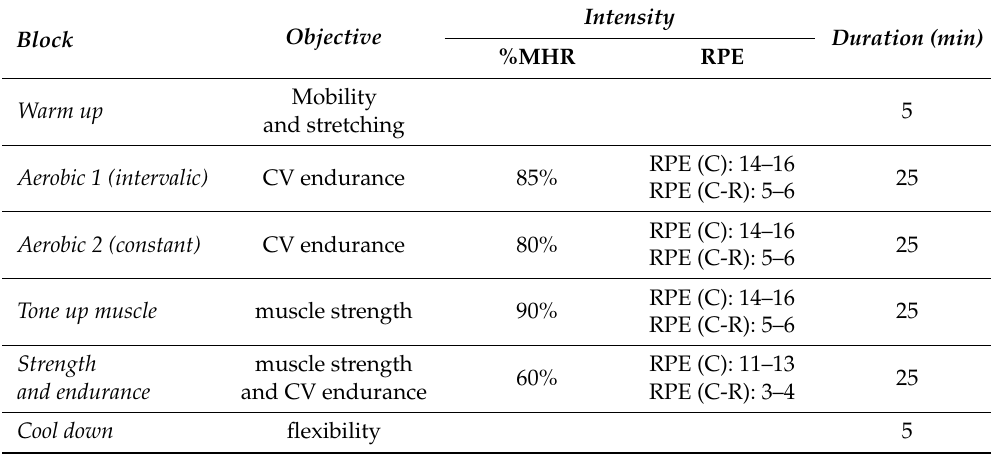
Table 1. Training progression for Active Murcia 3